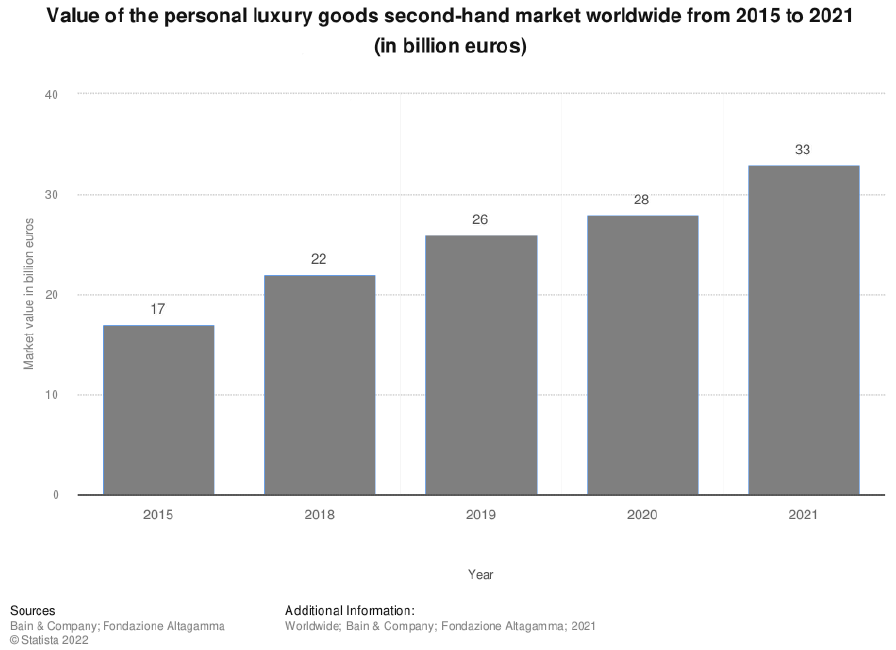
Figure 1. The use of a refurbished product in the second-hand